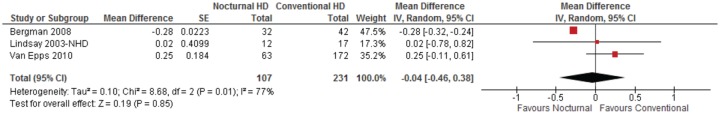
Comparative mean difference in hospital admission rate/patient-year for nocturnal home HD versus conventional HD.